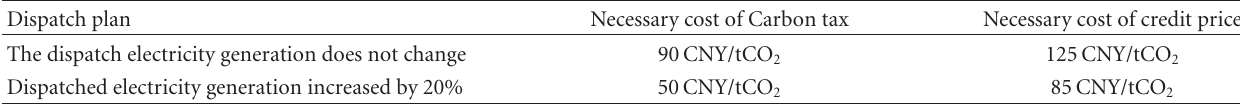
Table 6: The necessary cost of carbon tax and credit price with/without encouraging dispatch